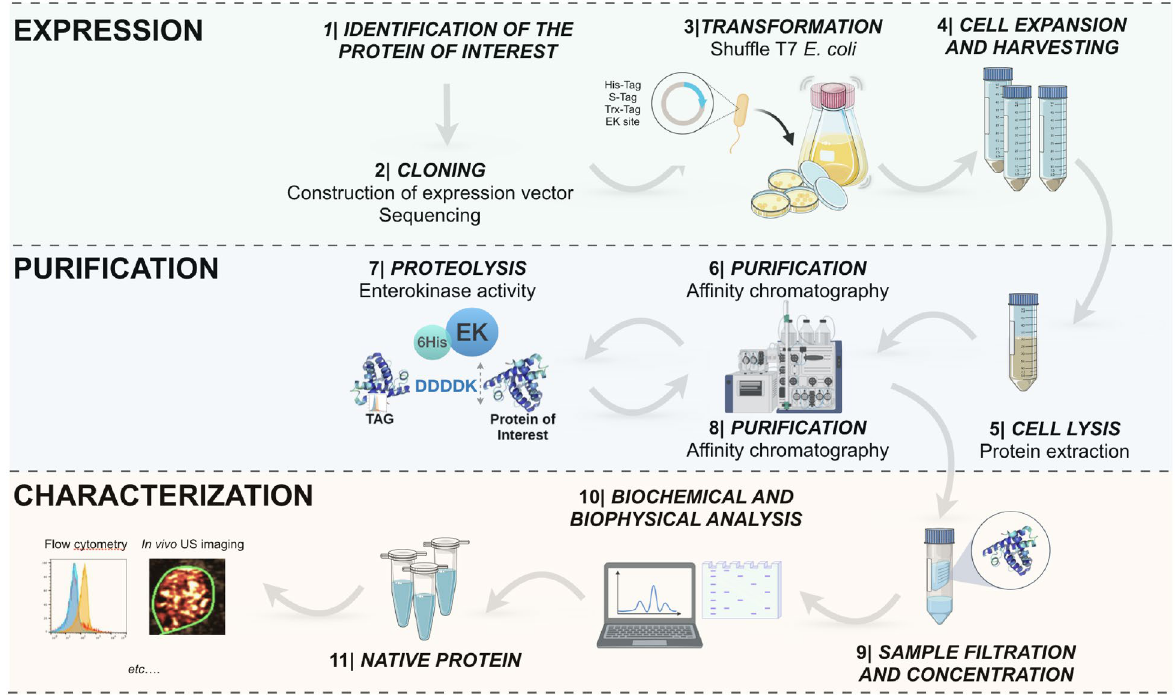
Figure 2. Schematic workflow showing the methodology employed for the construction, expression and purification of recombinant protein in its native